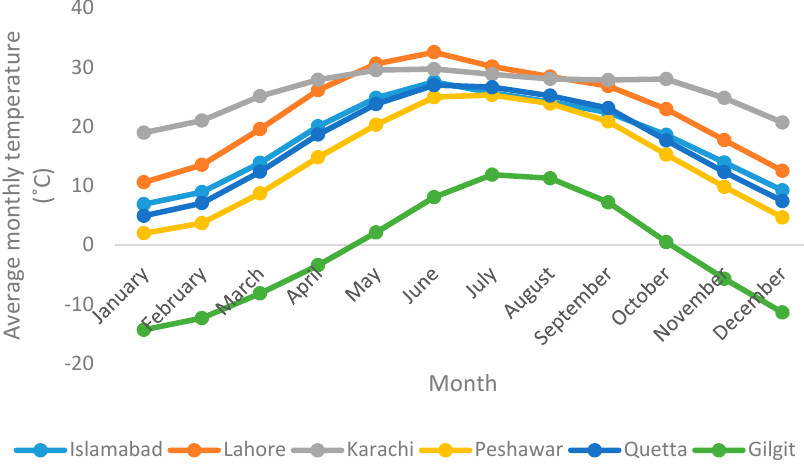
Figure 5. Average monthly earth’s surface temperature of Islamabad, Lahore, Karachi, Peshawar, Quetta and Gilgit.